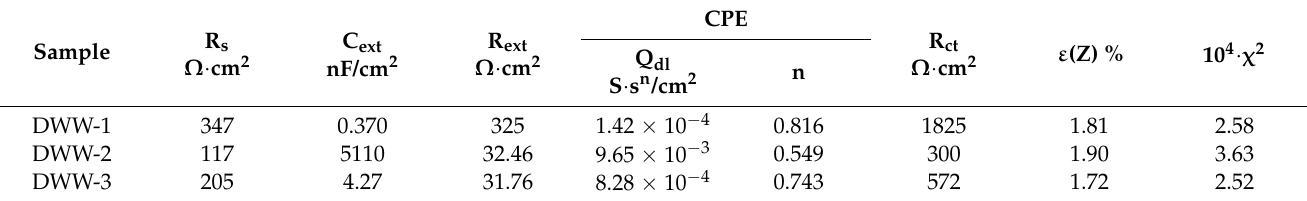
Table 7. Equivalent circuit element values for nodular cast iron samples immersed for 30 days in neutral, acidic, and basic synthetic wastewater.